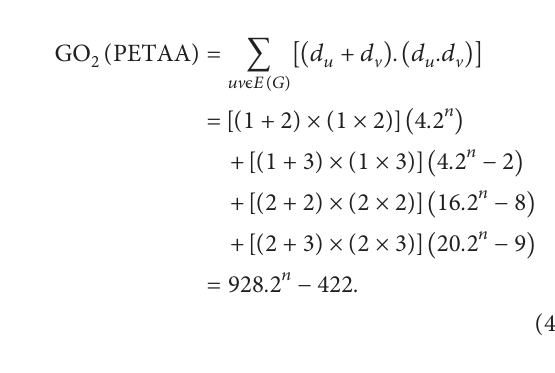
Figure 38: First hyper-Gourava